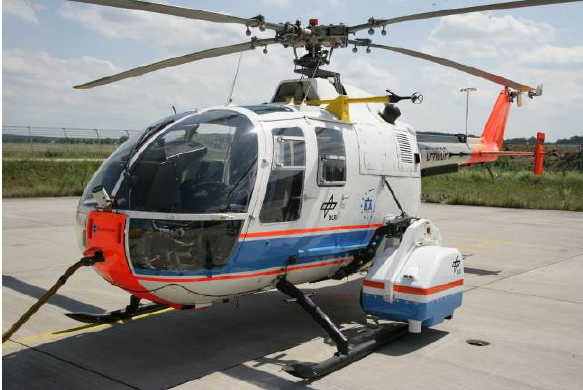
Figure 2: 4k camera system at DLR's research helicopter BO 105